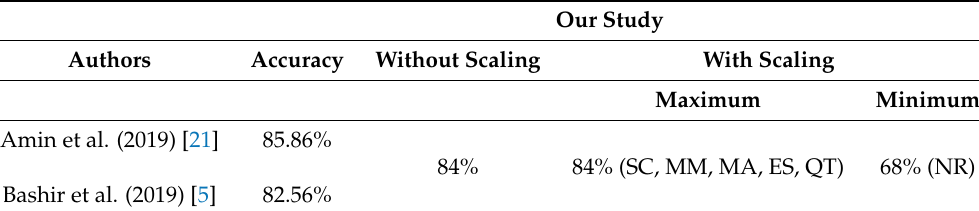
Table 9. Comparison with previous study—Logistic Regression.